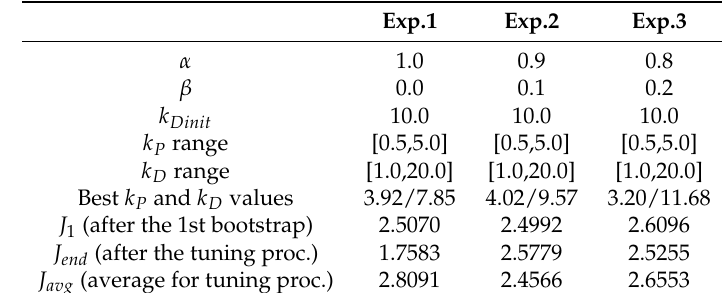
Figure 19. Step responses for the Bebop 2 UAV tuned with GLD method—variants: with and without addition mass (225 g tool accessories). Table 7. Results of real-world experiments—flying with the payload (tool accessories); for 2 bootstrap cycles, 56 iterations of the GLD method with low-pass filtration and (cid:101) = 0.05.